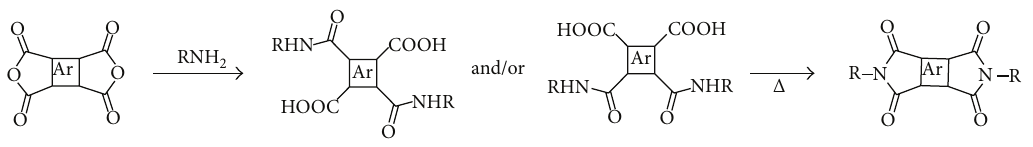
Scheme 2: Synthesis of diimides from aromatic